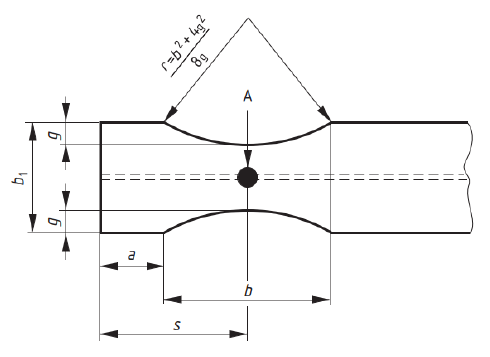
Fig. 2. Flange reduction geometry [11].